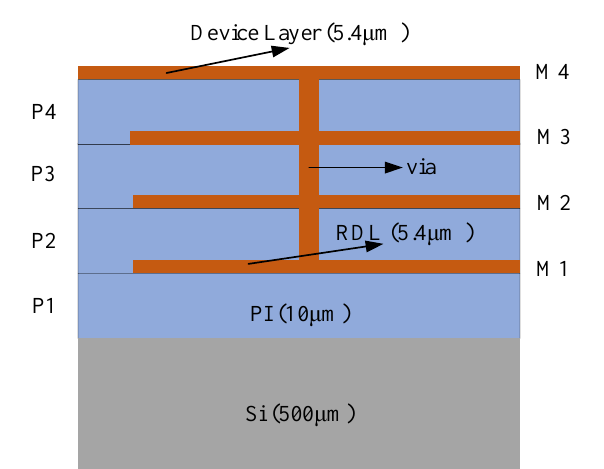
Figure 1. ( a ) Stack-up of the RDL process. ( b ) Configuration of the proposed filter (without Si layer). The vertical view of the proposed bandpass filter is shown in Figure 2., An array of periodic curved slots is etched on the top surface metal of the SIW cavity along the direc- tion of electromagnetic wave propagation. The top layer comprises three parts: the GCPW input (region I), the SIW – SSPP transition (region II), and the periodic array part for the propagation of the SSPP. The GCPW transmission line with lower loss and better heat dissipation is more appropriate for mmW integrated circuits; the filter is excited by two 50- Ω GCPW transmission lines with a pair of quarter wavelength coupling slots. Three curved slot cells of different lengths ( 𝐿 𝑠1 , 𝐿 𝑠2 , 𝐿 𝑠3 ), which are gradually increased in length, constitute region II. The increase is optimized to achieve smooth transition and mode matching between the SIW and SSPP, and then the SSPP mode is effectively excited. The dimensions of the BPF are calculated below.